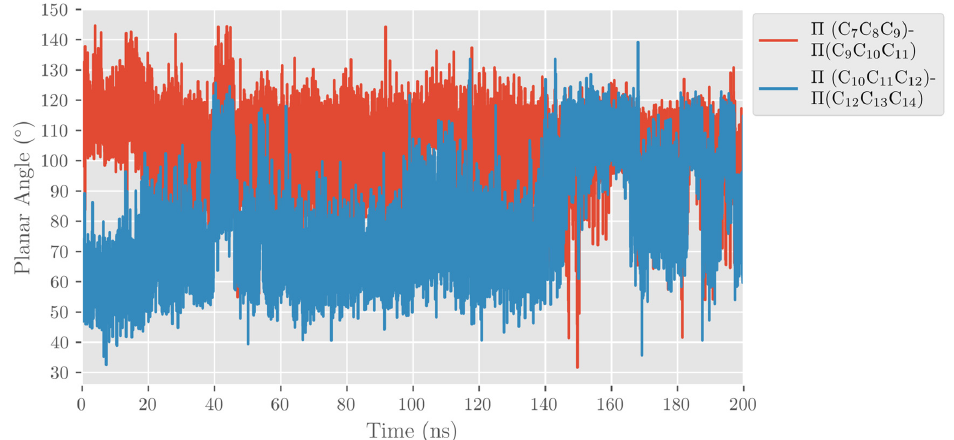
Figure 10. Evolution with time of the angle between planes formed by C 7 C 8 C 9 and C 9 C 10 C 11 (in red) and by C 10 C 11 C 12 and C 12 C 13 C 14 (in blue) along the MD replica 1 in hALOX12. 2.2. QM/MM Calculations of DHA Hydroperoxidation Catalyzed by hALOX12